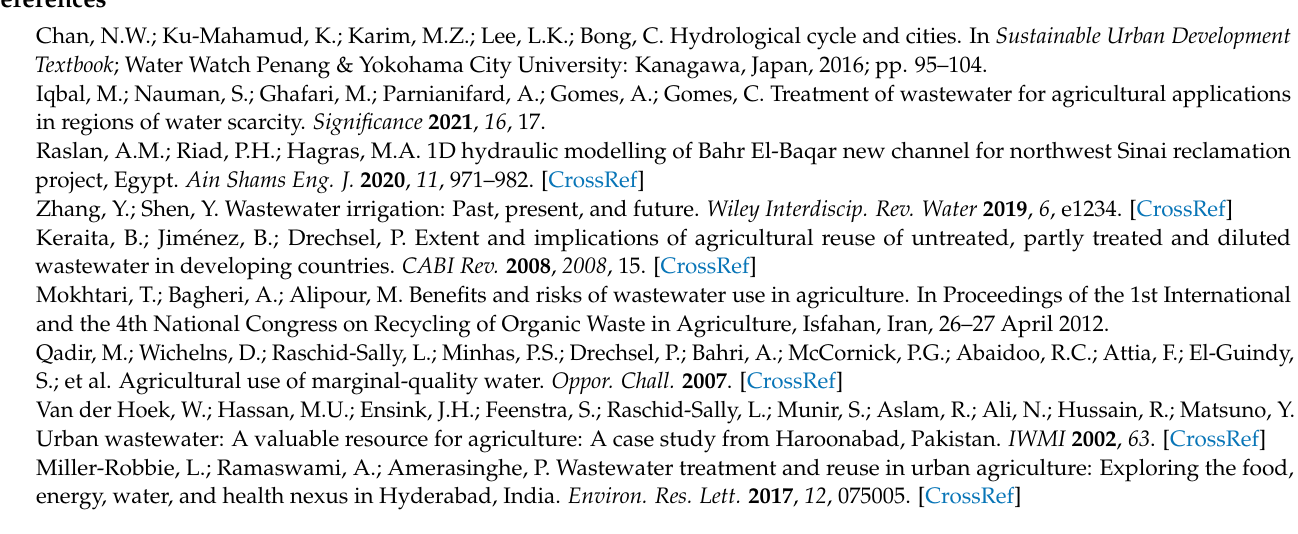
Figure A4. Salt mass balance in the ENDA.